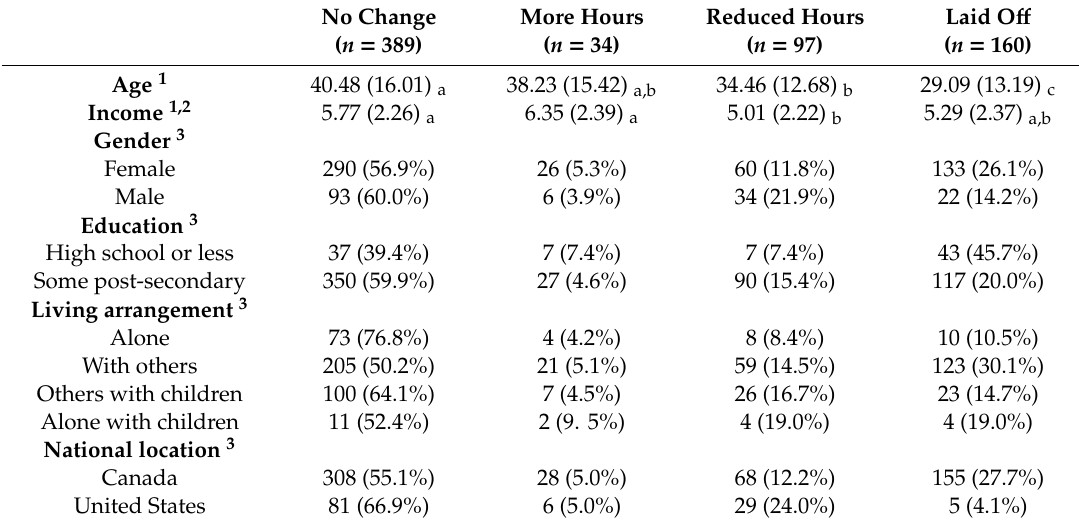
Table 2. Means ( SD ) / n (percentage of employment categories) associated with change of employment status.